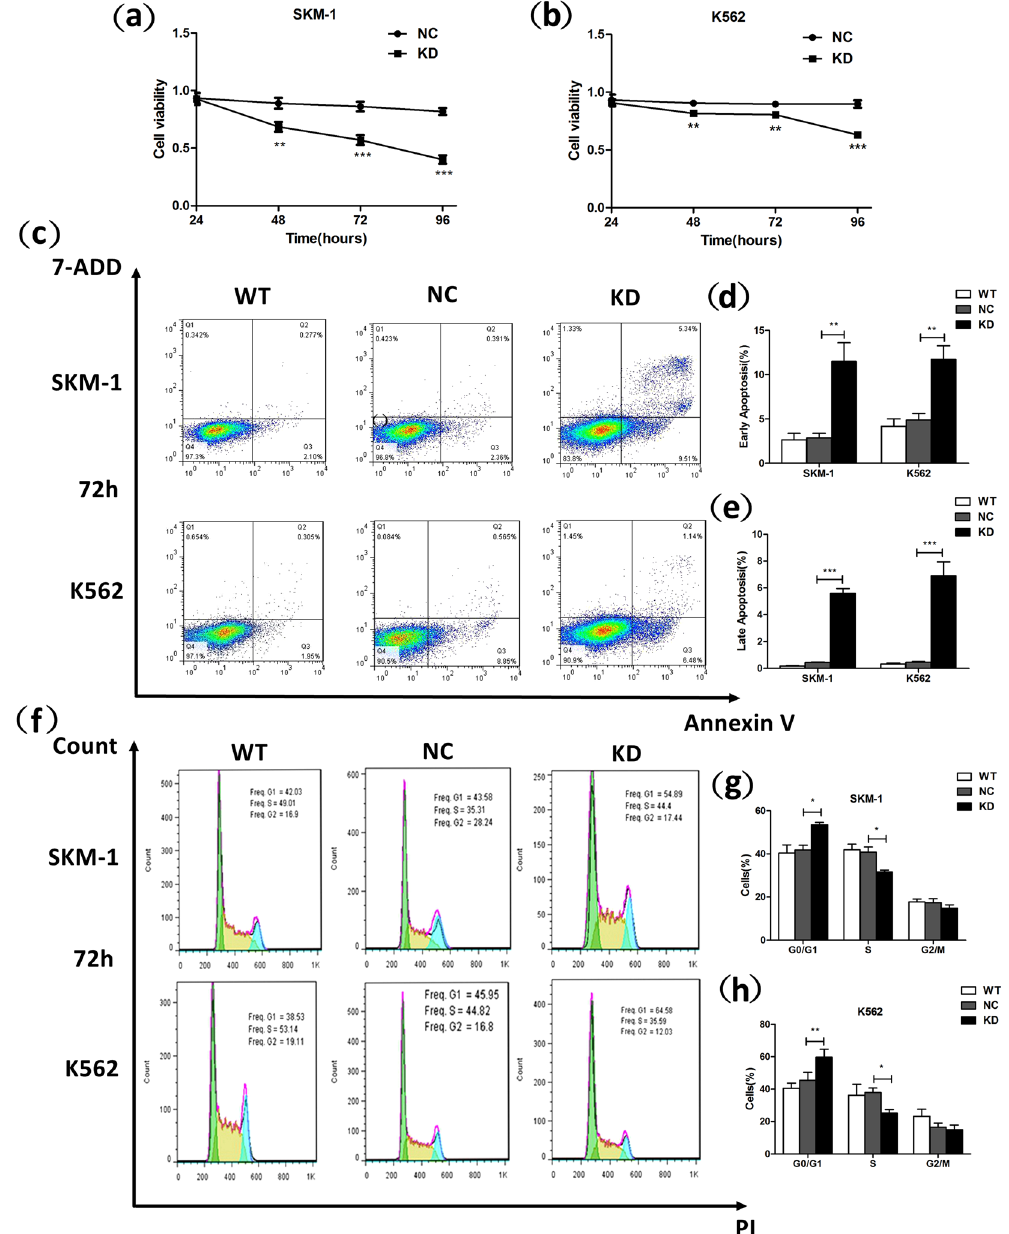
Figure 1. RPL23 knockdown blocks cell proliferation and induces apoptosis and cell cycle arrest. ( a , b ) The cell proliferation capacity of SKM-1/K562 cells was measured by a CCK-8 assay, and cellular viability was inhibited after RPL23 knockdown. ( c ) The representative flow graphic for apoptosis detection 72 h after efficient transfection of LV-RPL23-RNAi-GFP (KD group) and LV-RPL23-NC-GFP (NC group) in both SKM-1 and K562 cell lines is shown. The early-stage ( d ) and late-stage ( e ) apoptotic ratio increased after RPL23 knockdown. ( f ) The representative flow graphic for cell cycle detection 72 h after efficient transfection in both SKM-1 and K562 cell lines is shown. ( g , h ) The knockdown of RPL23 induced increases in the proportion of cells in the G0/G1 phase and a decreased proportion of cells in the S phase. Each assay was performed in triplicate. Unpaired Student’s t tests were used to calculate all p values shown in the figure. The data are expressed as the means ± S.E.M. WT: wild type; NC: RPL23-NC; KD: RPL23-KD. * p < 0.05; ** p < 0.01; *** p <